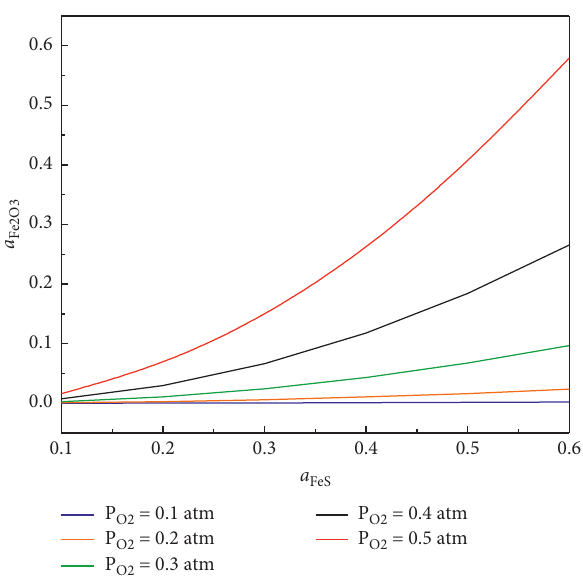
Figure 7: The relative relationship between a